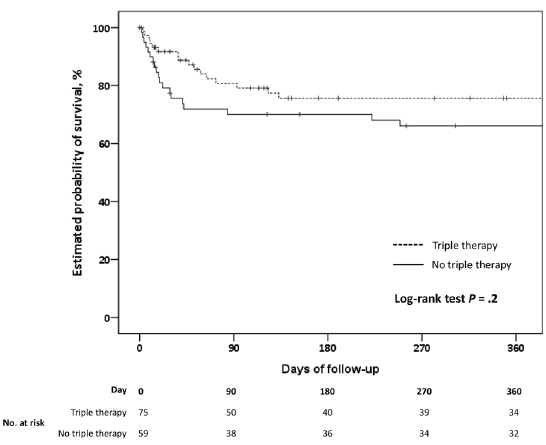
Fig. 1 Kaplan‑Meier estimated probability of survival for the 134 APS patients’ last episodes requiring intensive care unit admission with com‑ parison according triple therapy